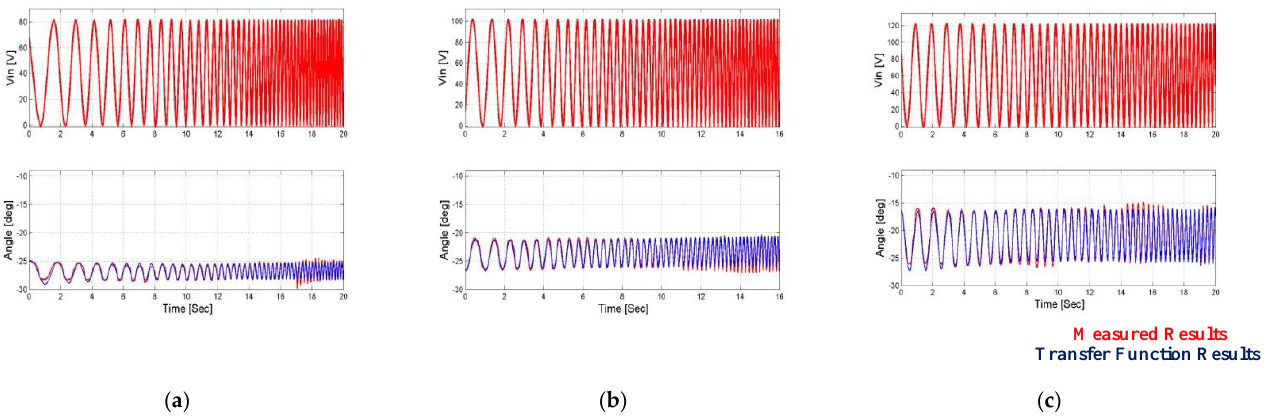
Figure 15. Comparison of uniform transfer function vs. measured output angle results when the second load is applied. ( a ) Vin = 80 V, ( b ) Vin = 100 V, and ( c ) Vin = 120 V.